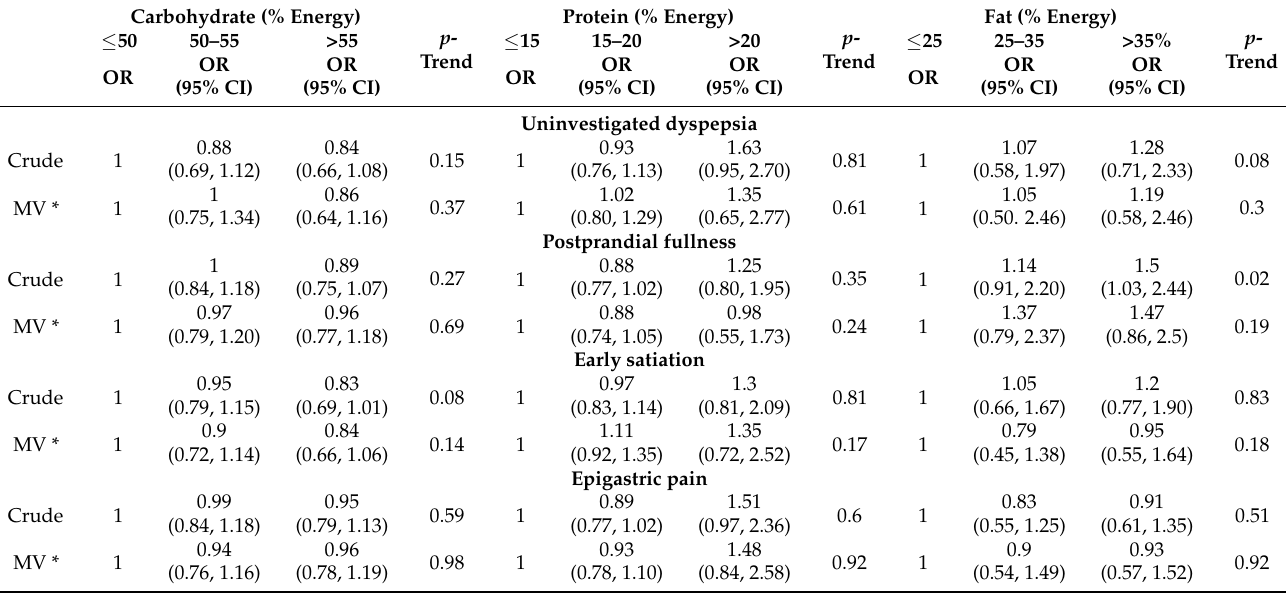
Table 4. Odds ratios and 95% confidence intervals in participants with uninvestigated dyspepsia and its symptoms according to categories of macronutrient intakes.